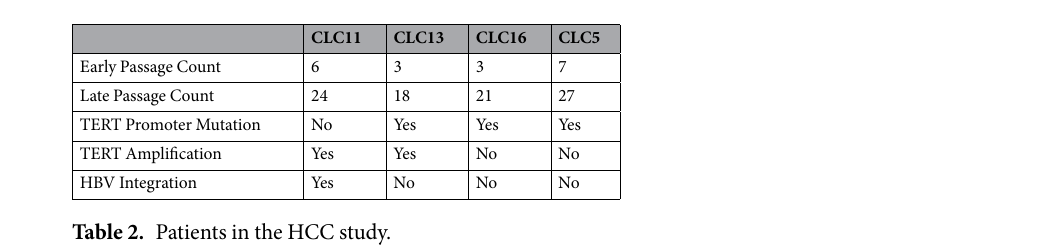
Figure 2. This figure shows estimates for the MSC samples produced by Telomerecat (left) and TelSeq (right). We expect to see a decrease in telomere length with additional passaging (P1 to P13), but consistent high telomere lengths in the two iPSC samples (iPSC1 and iPSC2).